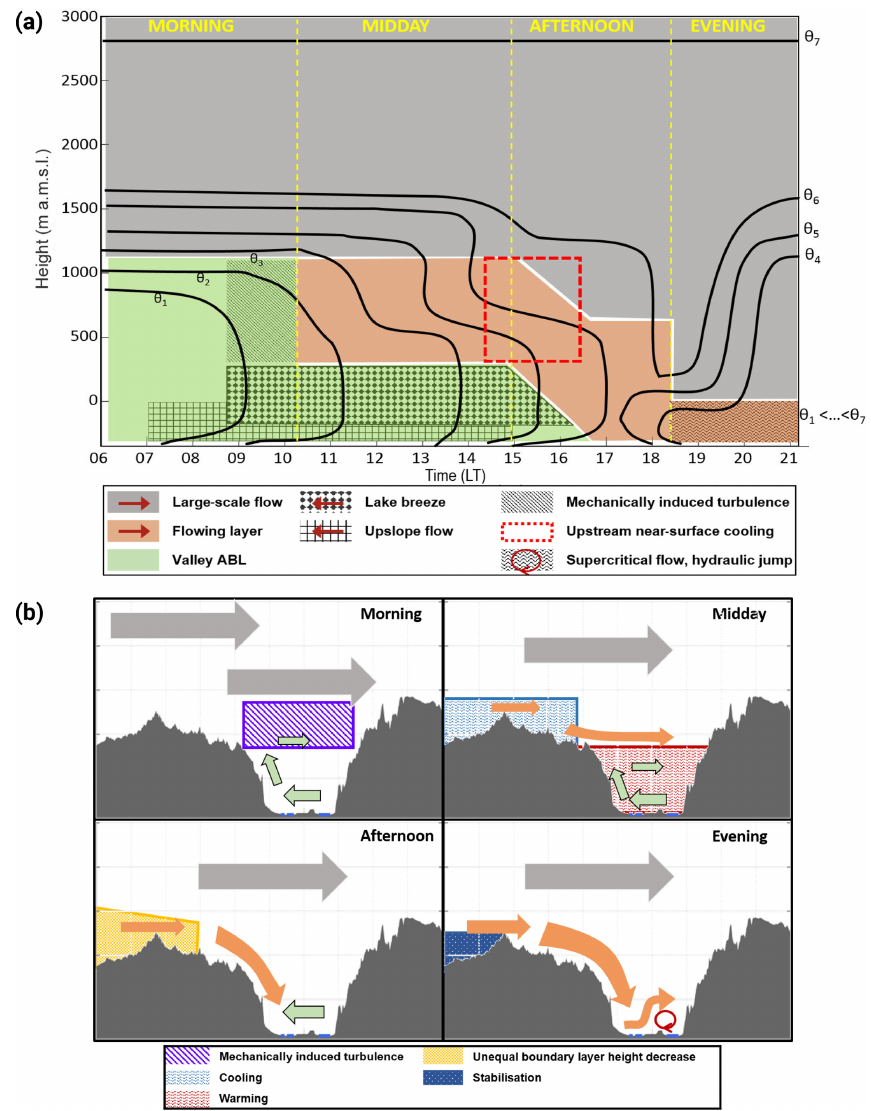
Figure 13. Conceptual model describing the different boundary layer processes in the valley on 16 August 2014. (a) The temporal evolution of the different layers and wind systems. The coloured areas refer to the distinct layers detected. Hatched areas describe distinct processes described in the text, and red arrows in the legend show the main wind direction in the respective layer. Panel (b) shows the wind systems (arrows) and the ongoing processes (shaded areas) leading to the next stage for morning, noon, afternoon, and evening.